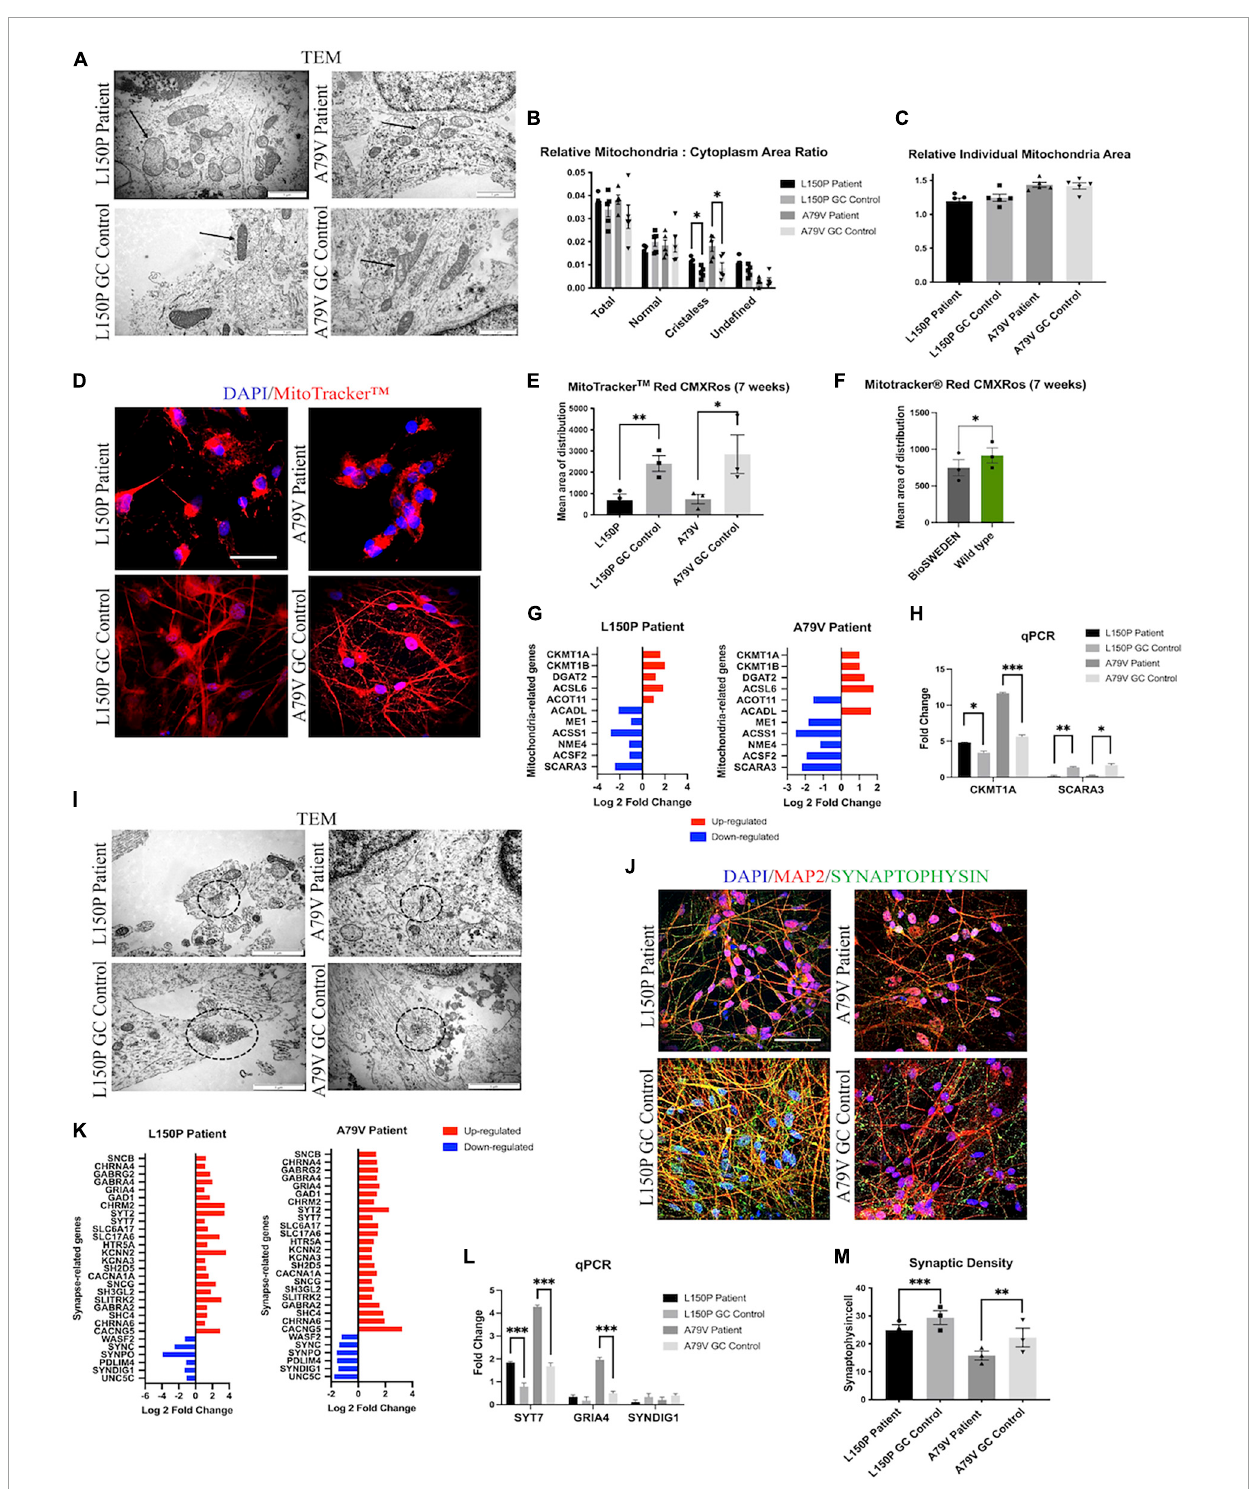
FIGURE2 fAD neurons display mitochondria and synaptic deficits. (A) TEM evaluation of mitochondria (indicated by arrows) ultrastructure. Scale bar 1 µ m. (B) Quantitative TEM morphometry assessment of relative mitochondria to cytoplasm ratio. (C) Quantitative TEM morphometry evaluation of relative individual mitochondria area. (D) Representative ICC images of MitoTracker TM analysis. Scale bar 50 µ m. (E) Quantitative assessment of MitoTracker TM analysis showing mean area of distribution in L150P and A79V hiPSC derived neurons. (F) Quantitative assessment of MitoTracker TM analysis showing mean area of distribution in K3P53 and BioSweden hiPSC derived neurons. (G) Overview of top significantly differentially expressed genes associated with mitochondria. (H) qPCR validation of key differentially expressed genes associated with mitochondria identified by RNA-seq analysis. (I) TEM evaluation of synapses and synaptic vesicles (circled). Scale bar 1 µ m. (J) Representative ICC images of synaptophysin expression. Scale bar 50 µ M. (K) Overview of top significantly differentially expressed genes associated with synapses. Adjusted p-value is displayed in Supplementary Table 2C . (L) qPCR validation of key differentially expressed genes associated with synapses identified by RNA-seq analysis. (M) Quantitative assessment of synaptophysin expression. Results are displayed as mean ± standard error of the mean (SEM) from three